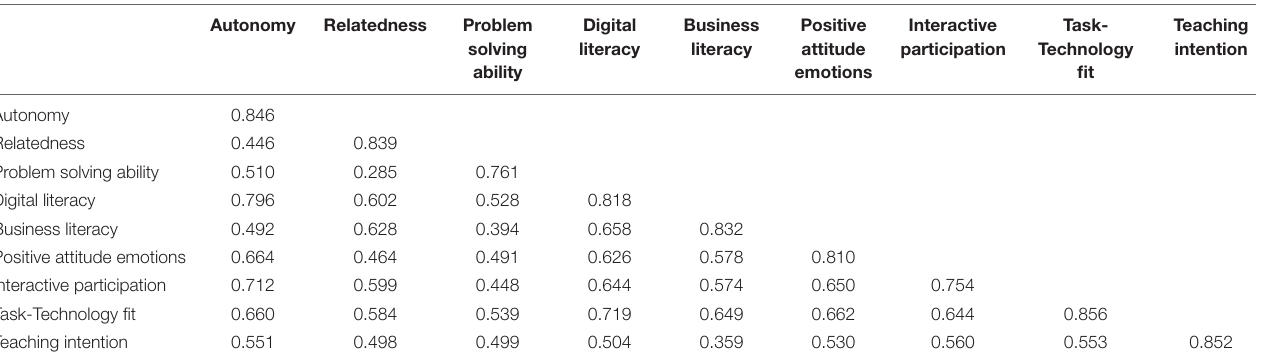
TABLE 4 | Discriminative validity (Fornell and Larcker criteria) of research model.